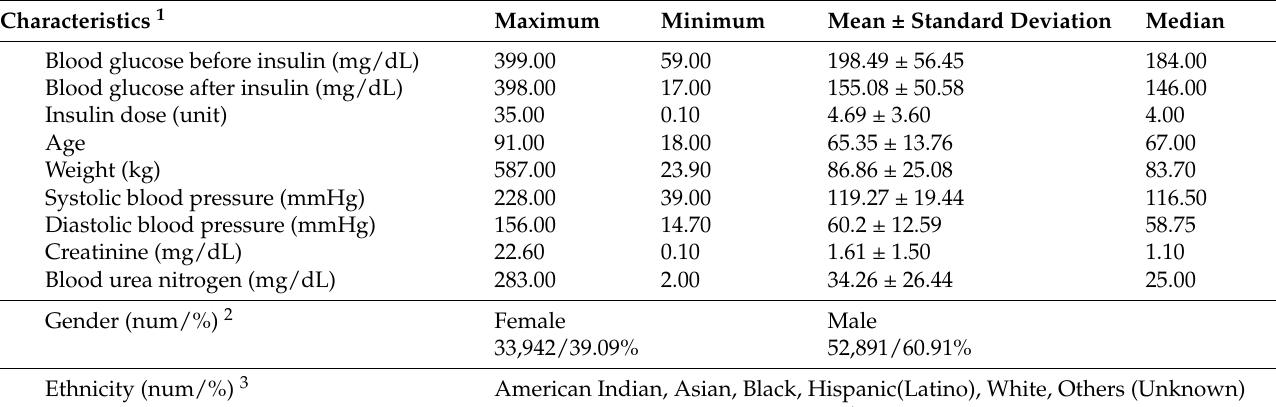
Table 1. Statistical description of the 11 characteristics in the